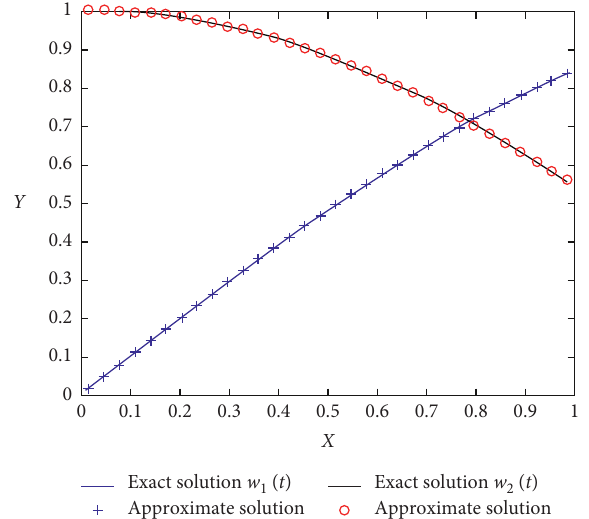
Figure 2: Comparison of exact and approximate solution for N � 32 for Problem